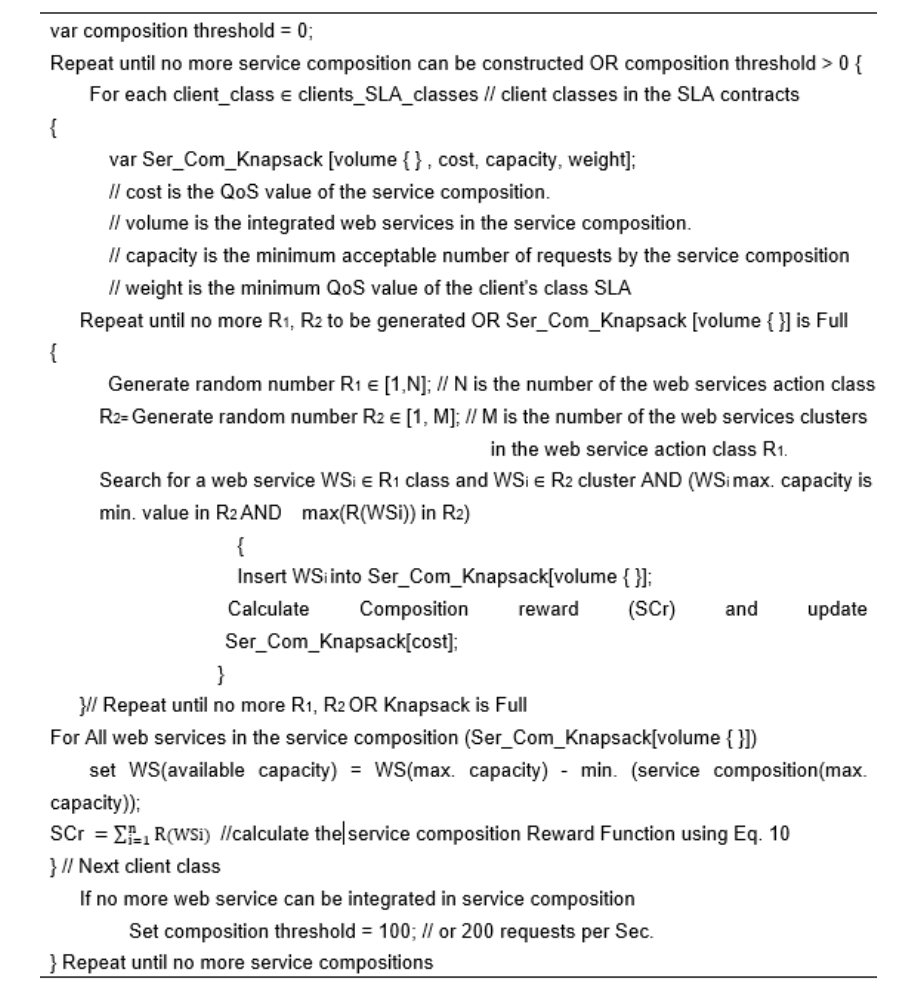
Figure 2. Service composition using the knapsack algorithm .